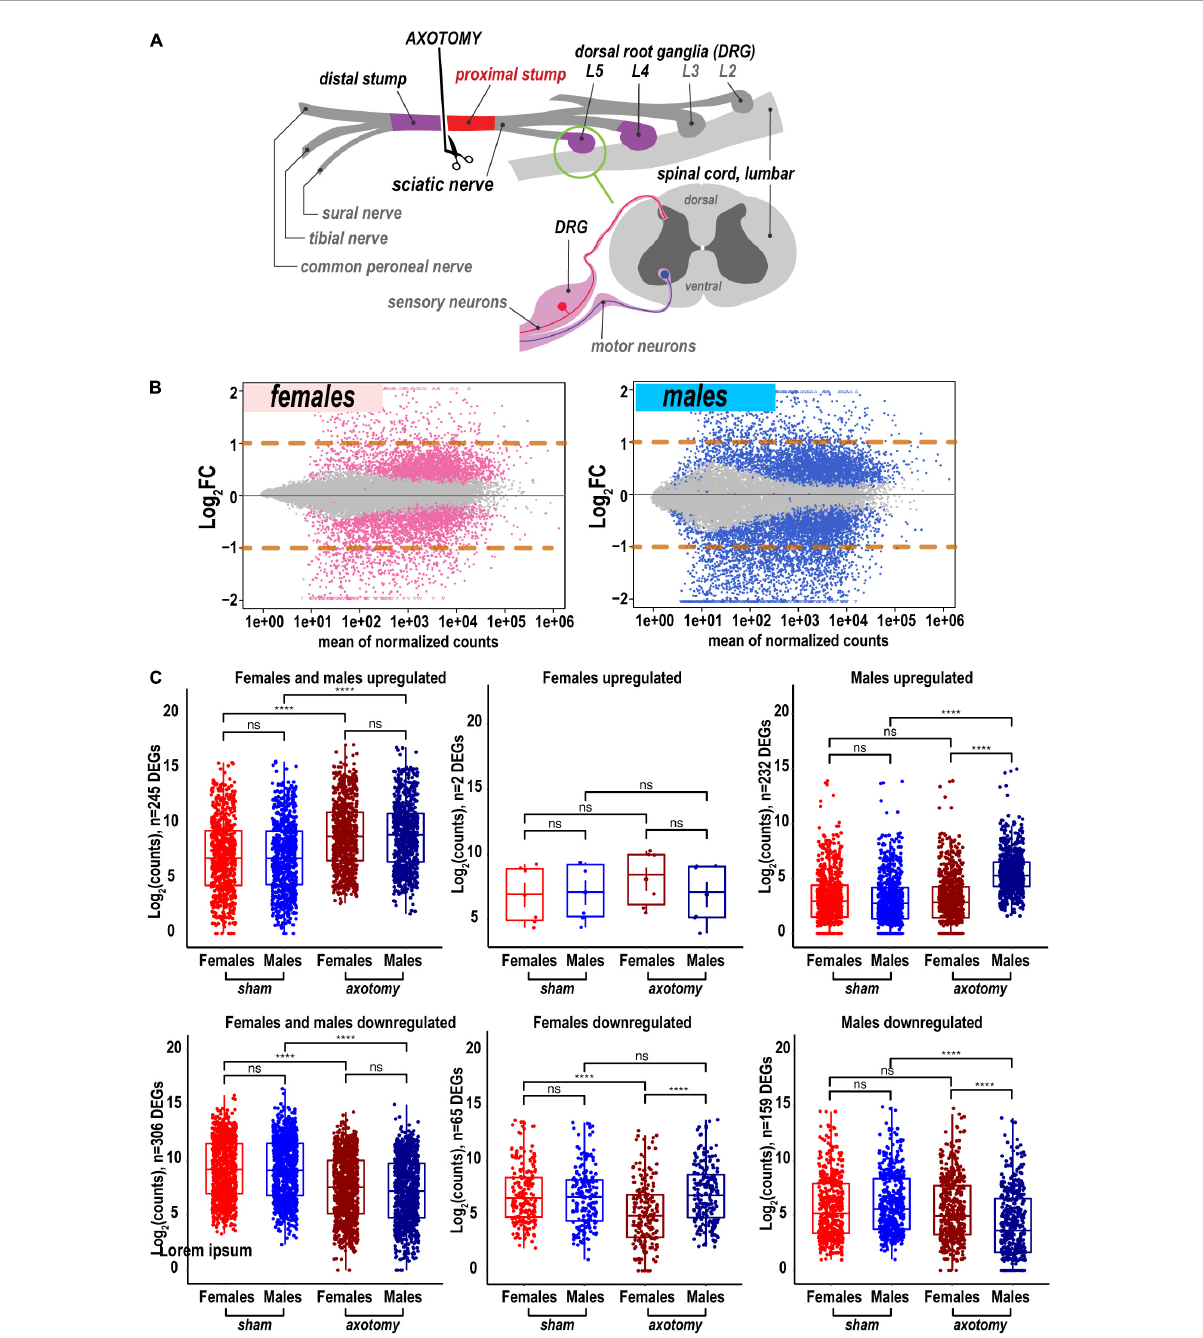
FIGURE1 Global transcriptional changes in proximal nerve 24 h post-axotomy lead to a larger number of increased transcripts in males. (A) A schematic of the sciatic nerve axotomy followed by ipsilateral proximal stump tissue analysis. (B) MA plots display log 2 FC and mean counts normalized using DESeq2 and adaptive t-prior apeglm method. The left and right panels show up- and downregulated genes in females (red dots) and males (blue dots), respectively. Dots indicate differentially expressed genes (DEGs) with P adj < 0.1. Orange dashed lines show log 2 FC thresholds above 1 or below –1. (C) Scatter plots of significant up- and downregulated DEGs in females (light and dark red dots) and males (light and dark blue dots). Light and dark color intensity indicate DEGs in sham or axotomy samples ( n = 6 mice/group, 2 mice/sample (pooled), 3 sample/group), respectively. DEGs (P adj < 0.1) were filtered by log 2 FC either above 1 or below –1 (two-fold change or larger). Dots on the Y-axis correspond to the absolute gene expression measured as normalized mean counts following logarithm transformation of gene counts [log 2 (counts)] by the normTransform method in DESeq2 . Specific expression data for DEGs is available in Supplementary Table 1 and the GEO repository (accession numbers GSE182713 and GSE182709). Pairwise comparisons were made using the analysis of variance (ANOVA) with